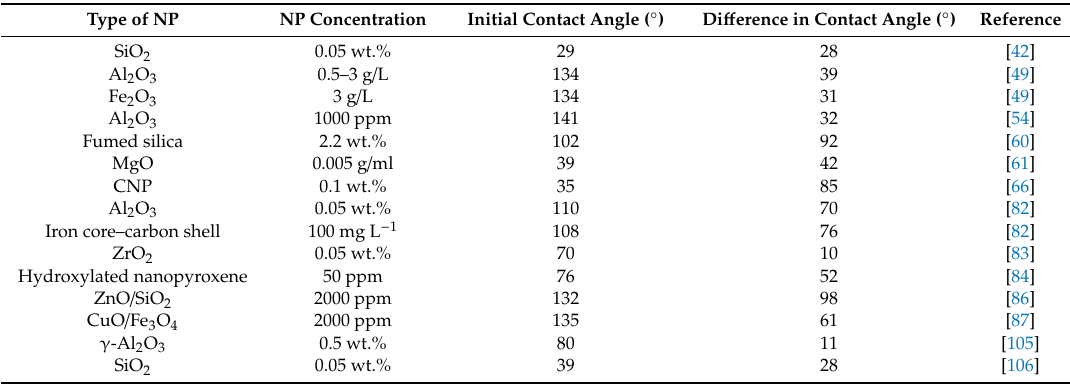
Table 3. E ff ect of nanoparticles on contact